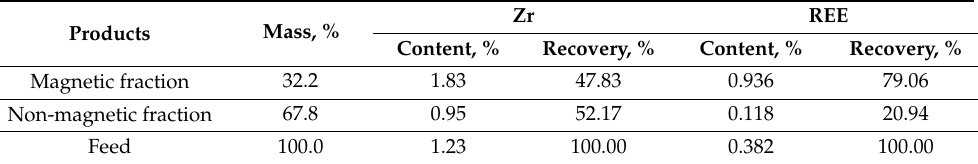
Table 3. The results of WHIMS for Eudialyte ore sample from Norra Kärr.